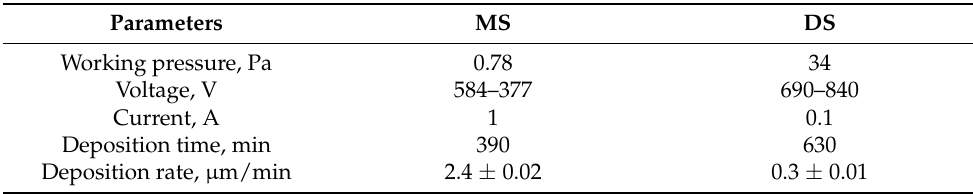
Table 1. Main deposition parameters of sputtering processes (MS and DS) used in the experimental tests and calculated deposition rate.